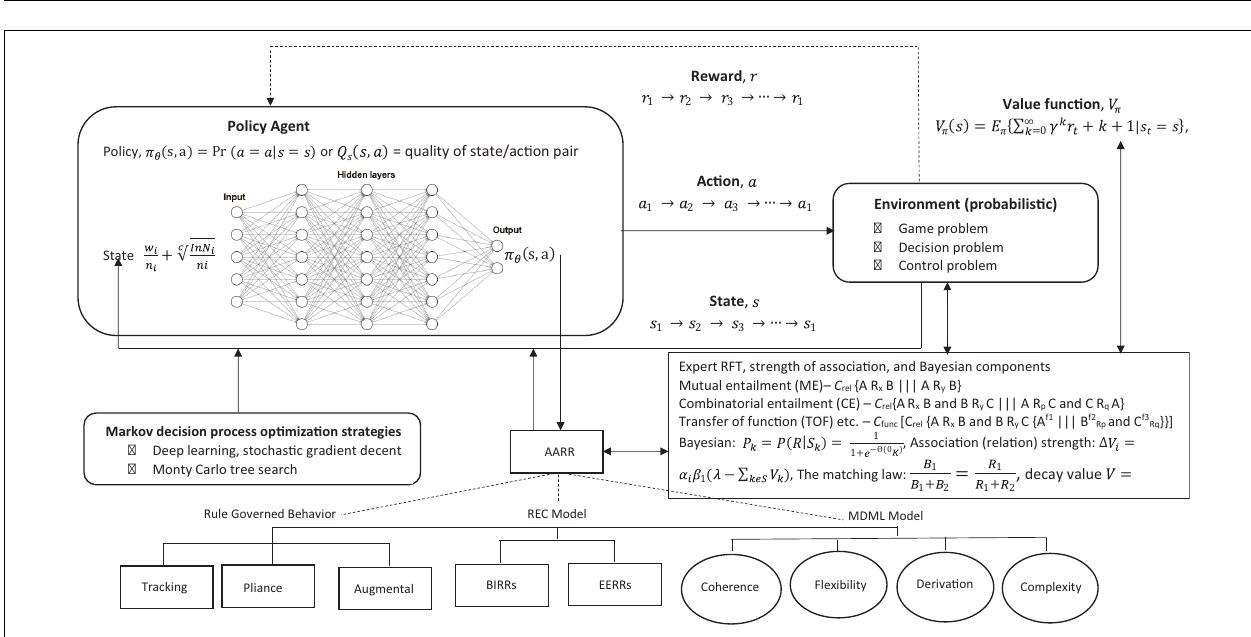
taking action a when in state s under a policy V π ( s ) , gives the expected reinforcing return when starting at s and following a given policy π